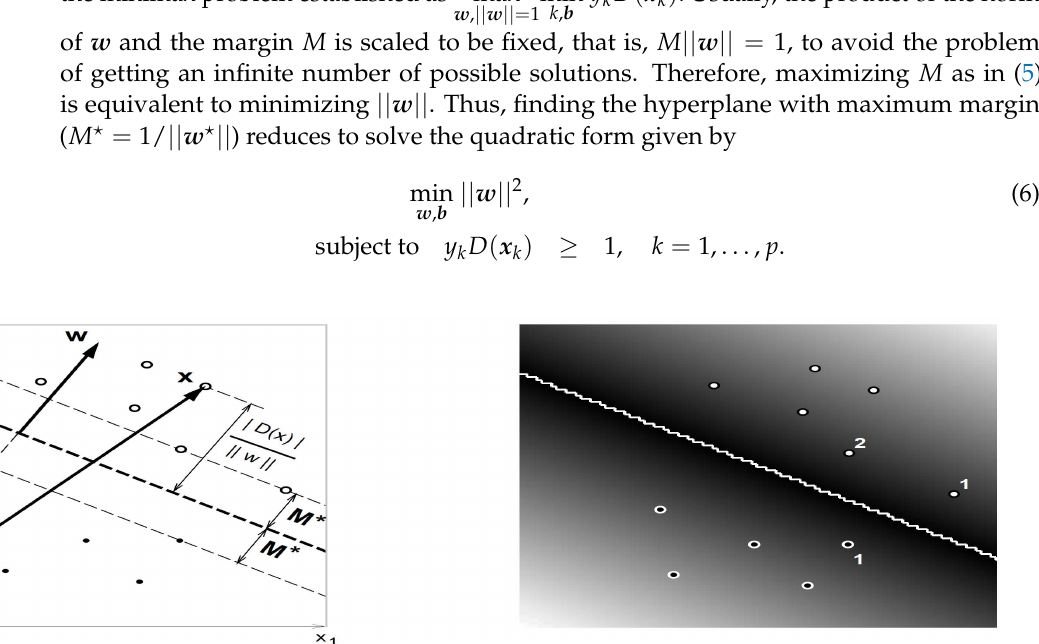
Figure 1. Plot of the maximum margin linear decision function D ( x ) = w (cid:62) x + b ( ϕ ( x ) = x ) ( left ) and an image of it ( right ). The gray levels encode | D ( x ) | , solid black corresponds to D ( x ) = 0 , and the numbers indicate the supporting vectors (Source: